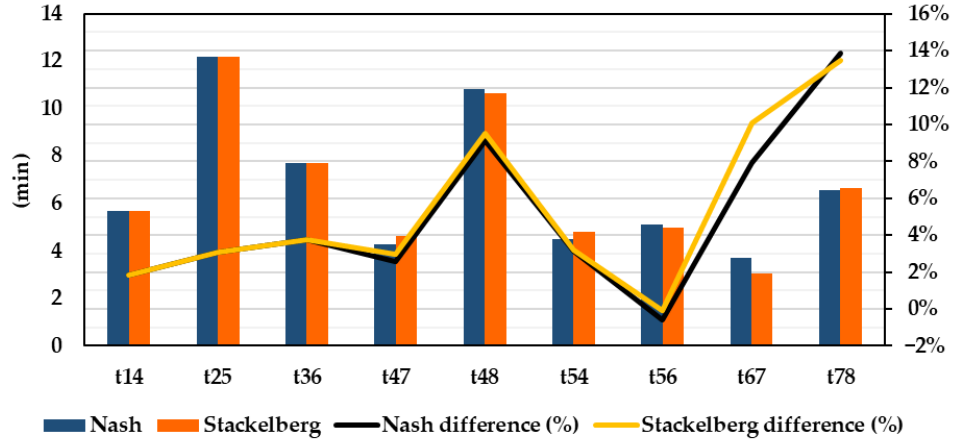
Figure 10. Compared travel times through individual links to the road network for scenario #3. (Nash Figure 10. This is a figure. Schemes follow the same formatting. If there are multiple panels, they and Stackelberg differences (%) represent the percentage increase in travel time through each link should be listed as: ( a ) Description of what is contained in the first panel. ( b ) Description of what is compared to the results of scenario #1). contained in the second panel. Figures should be placed in the main text near to the first time they are cited. A caption on a single line should be centered.